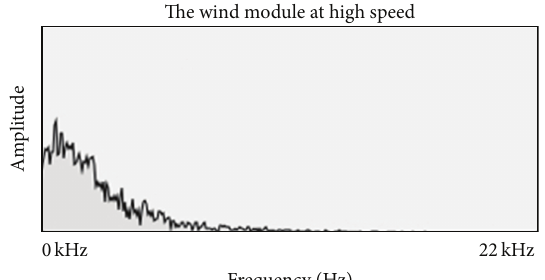
Figure 15: Spectrogram showing a snapshot of the wind module at high speed.